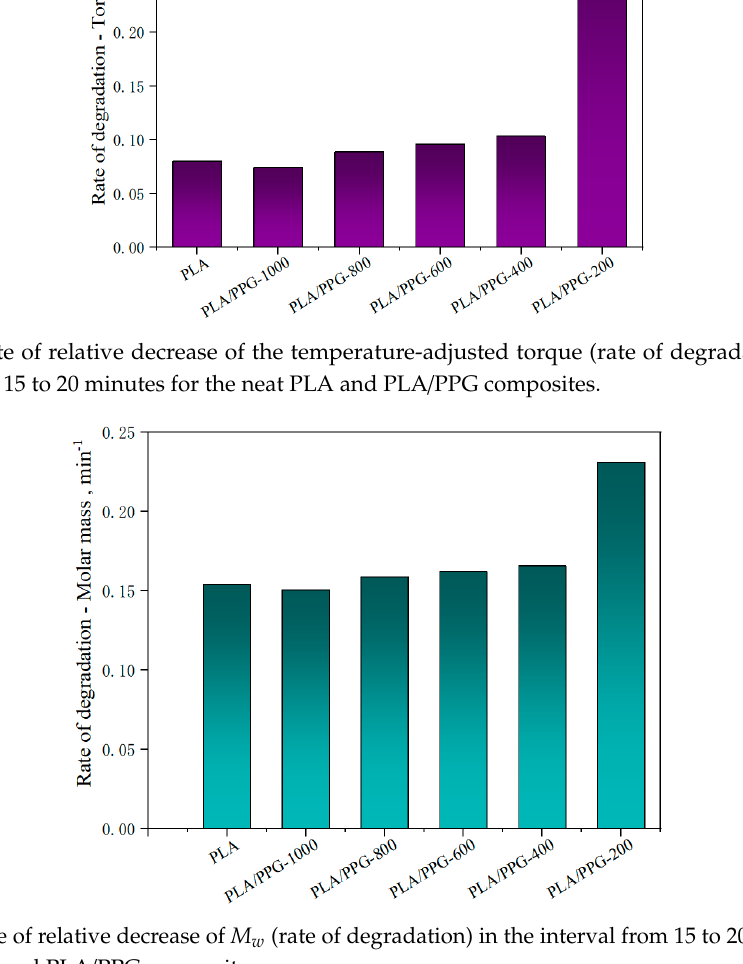
Table 2. Terminal process parameters for the neat PLA and PLA/PPG composites (15–20 minutes).